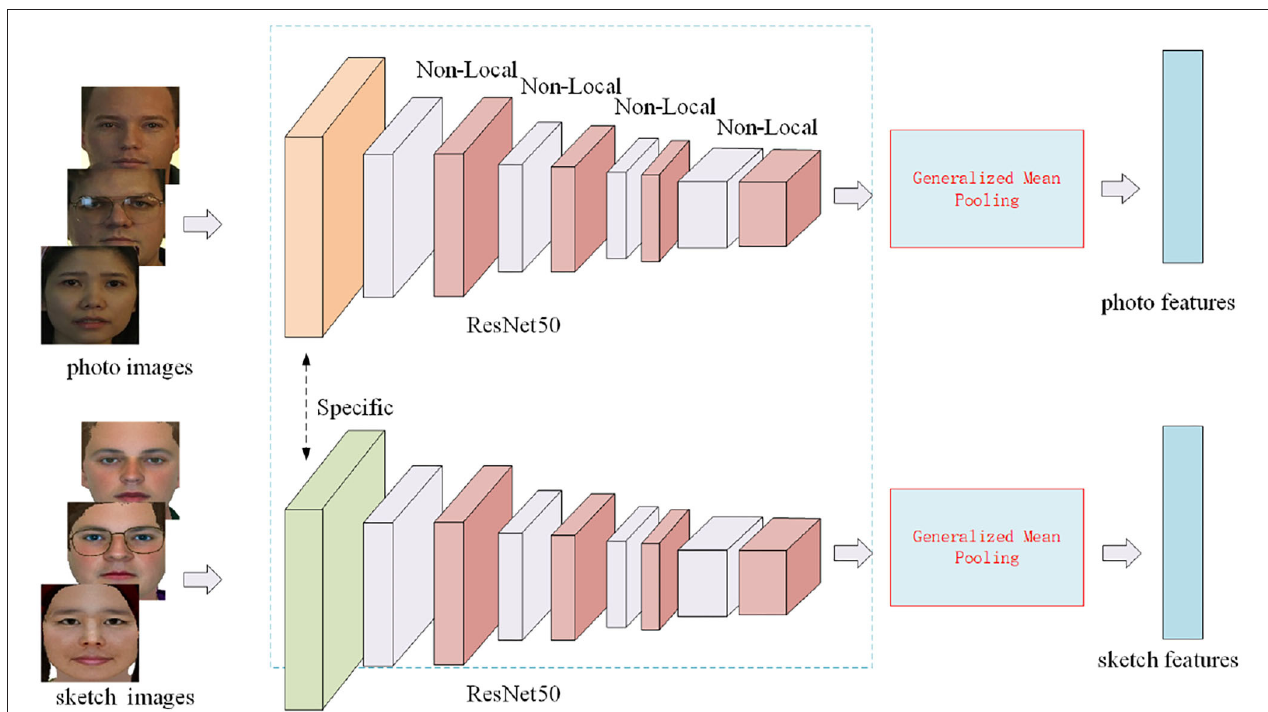
FIGURE 2 | The overall structure of MAE for sketch face